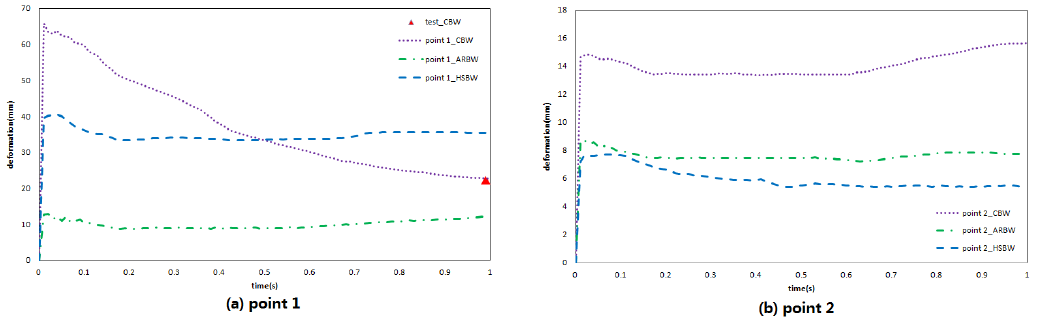
Figure 11. Deformation history of the evaluation points of blast walls: ( a ) point 1, ( b ) point 2.